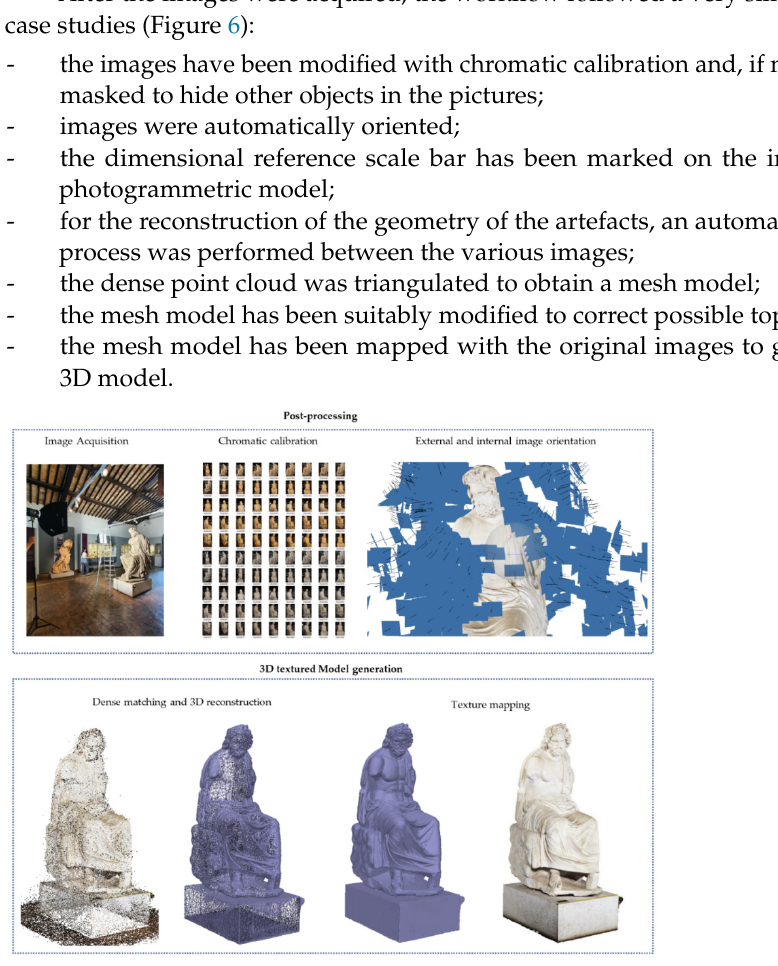
Figure 6. The digital photogrammetric process applied to the sculptures.